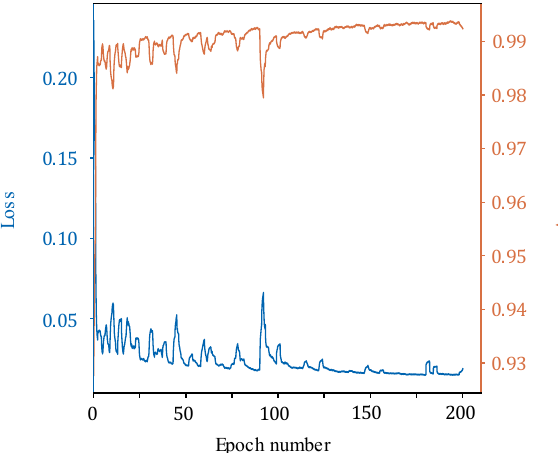
Figure 6. Evolution of the point-wise cross-entropy loss and the overall training accuracy with the epoch number for KPConv